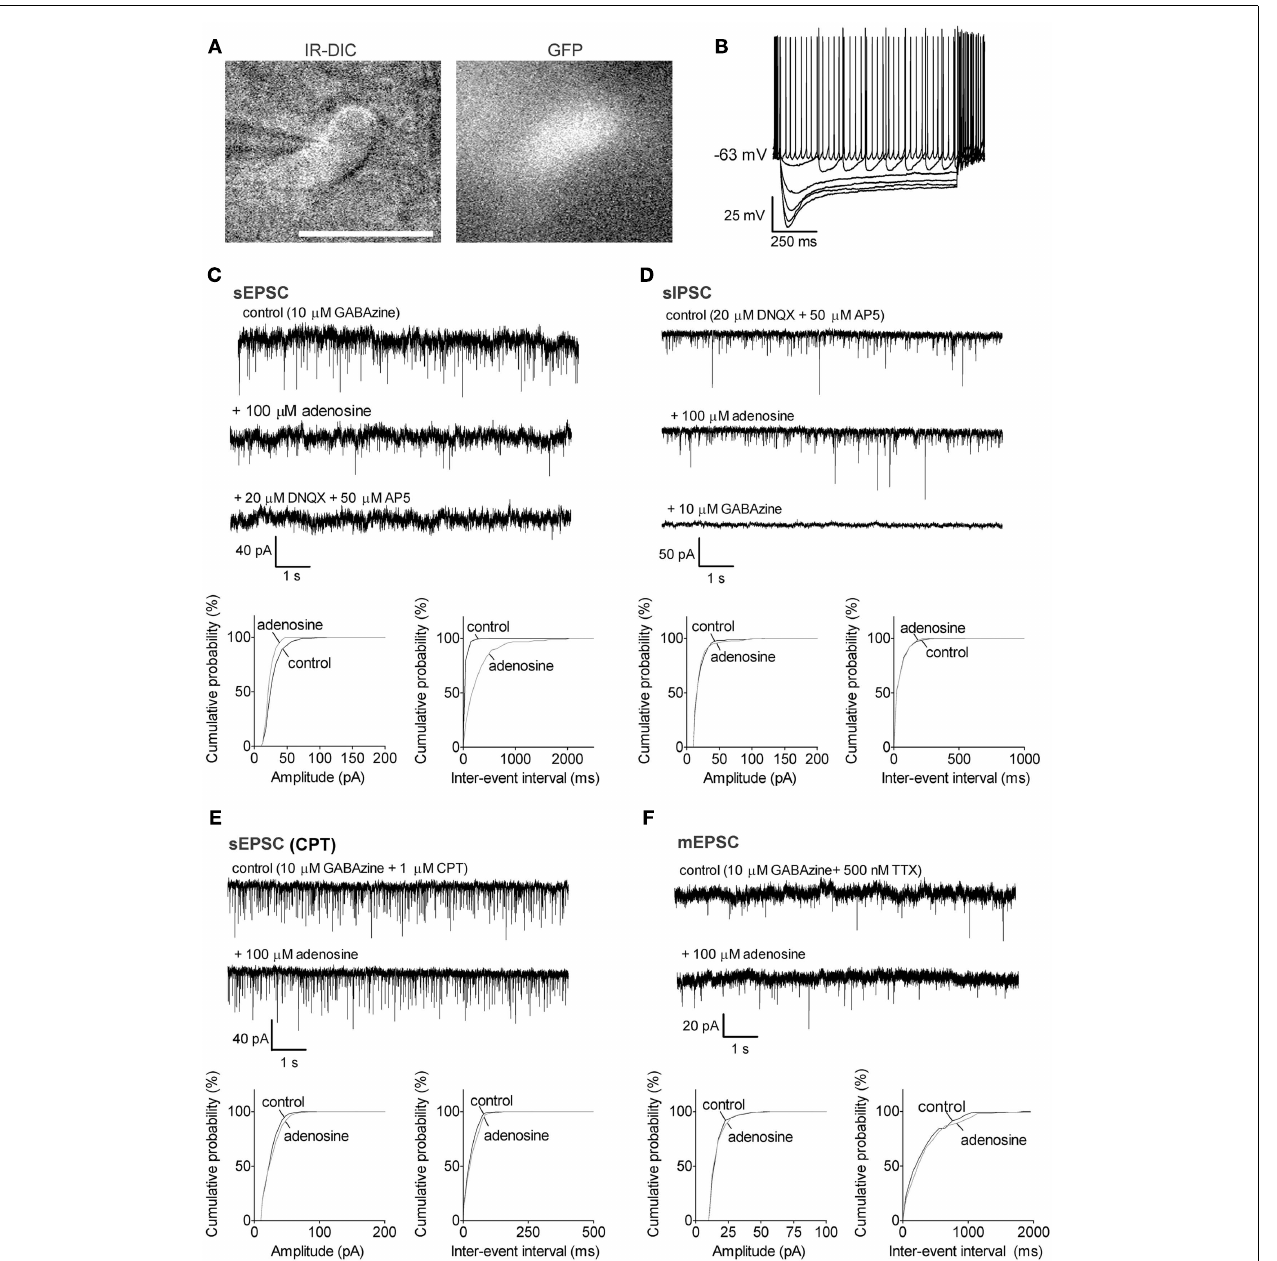
amplitude of spontaneous inhibitory postsynaptic currents (sIPSC).The ionotropic glutamate receptor antagonists, DNQX and AP5 were used to isolate inhibitory synaptic events. A KCl-based intracellular solution and a holding potential of − 90mV were used to enhance the driving force for chloride. KCl-based intracellular solution shifted the reversal potential in the depolarizing direction, thus the recorded currents are inward going. (E) The adenosine A1 receptor antagonist, 1 µ M CPT, blocked the effect of adenosine on sEPSCs. (F) Adenosine did not affect the frequency or amplitude of miniature excitatory postsynaptic currents (mEPSCs), recorded in the presence of tetrodotoxin (TTX) and GABAzine. (C–F) Top traces: 10s-long representative traces from one neuron under each recording condition. Bottom graphs: cumulative probability histograms of amplitude (left) and inter-event interval (right) of 1min recordings from the same neuron. Distributions were compared using the Kolmogorov–Smirnov